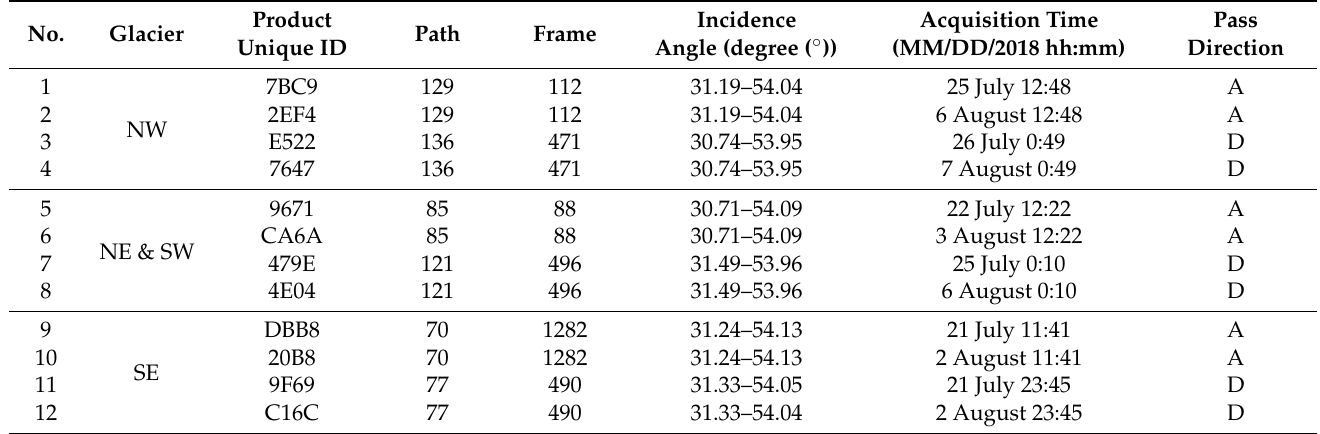
Table 1. Sentinel-1A images used for this study (A = Ascending D = Descending).